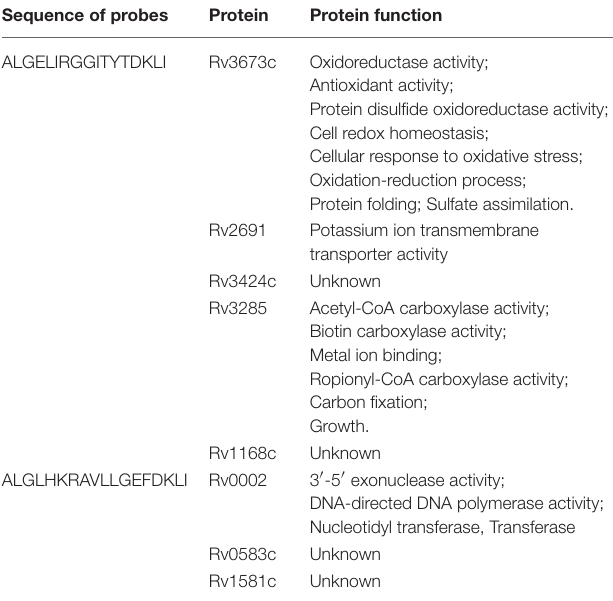
TABLE 6 | Identified potential ligands of γδ T cells by screening the Mycobacterium tuberculosis protein chip. Sequence of